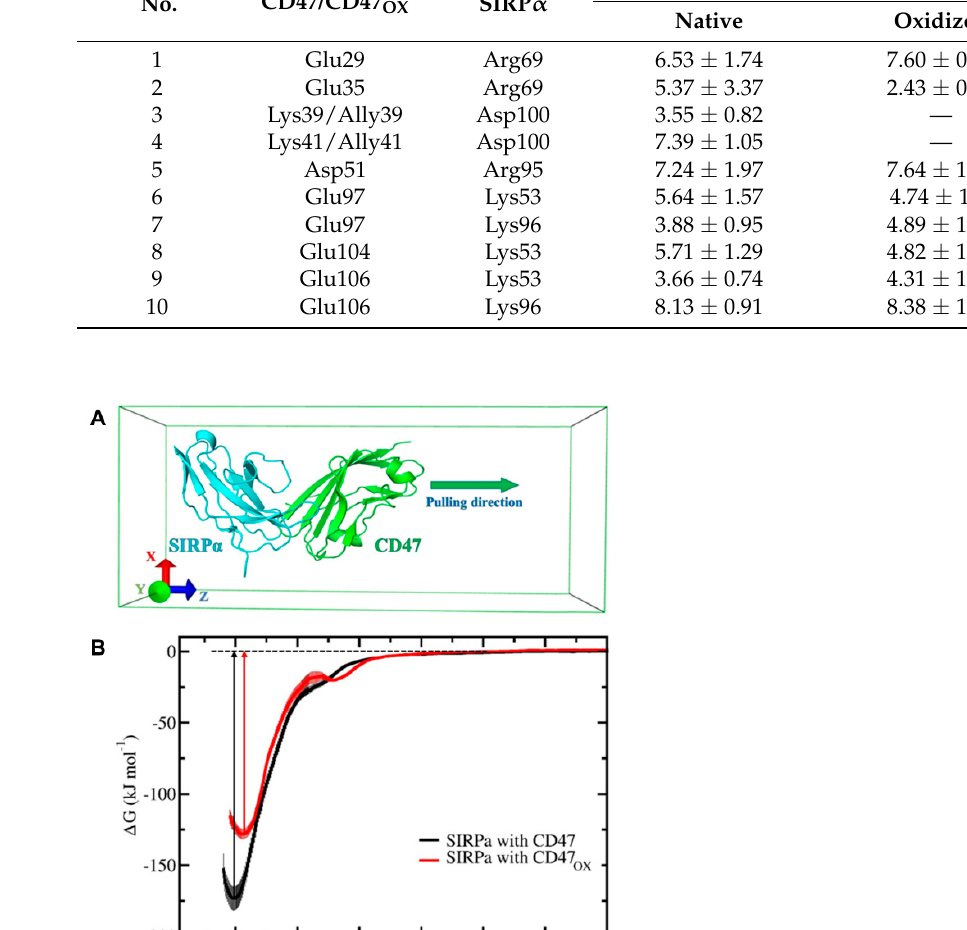
Table 1. Calculated salt bridge distances formed between CD47/CD47 OX and SIRP α systems.